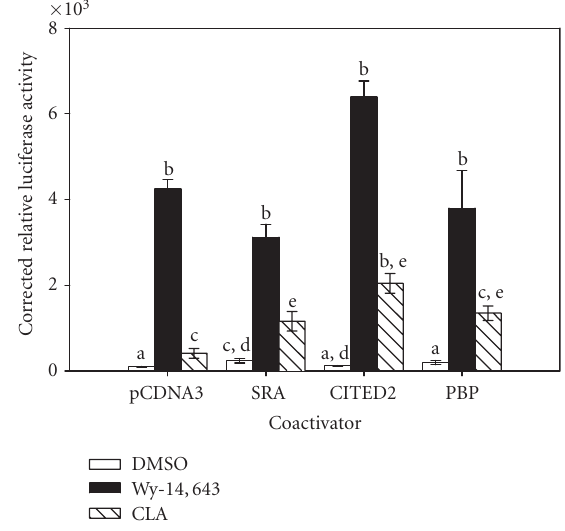
Figure 1: E ff ects of various coactivators on the activation of PPAR α by Wy-14,643 and CLA. COS-1 cells were transiently transfected with pM/PPAR α , GAL4 reporter, and coactivator expression plas- mids or empty vector control (total DNA per well was held con- stant). Cells were treated for 6 hours with 50 μ M Wy-14,643, 100 μ M CLA, or DMSO. Luciferase activity was measured and corrected for transfection e ffi ciency and extraction yield ( n = 3). Relative values are corrected to untreated pcDNA3 bar (100%). Bars with di ff er- ent letters above are significantly di ff erent from each other (Tukey’s multicomparison test, P < . 05), representative of 2 independent ex-